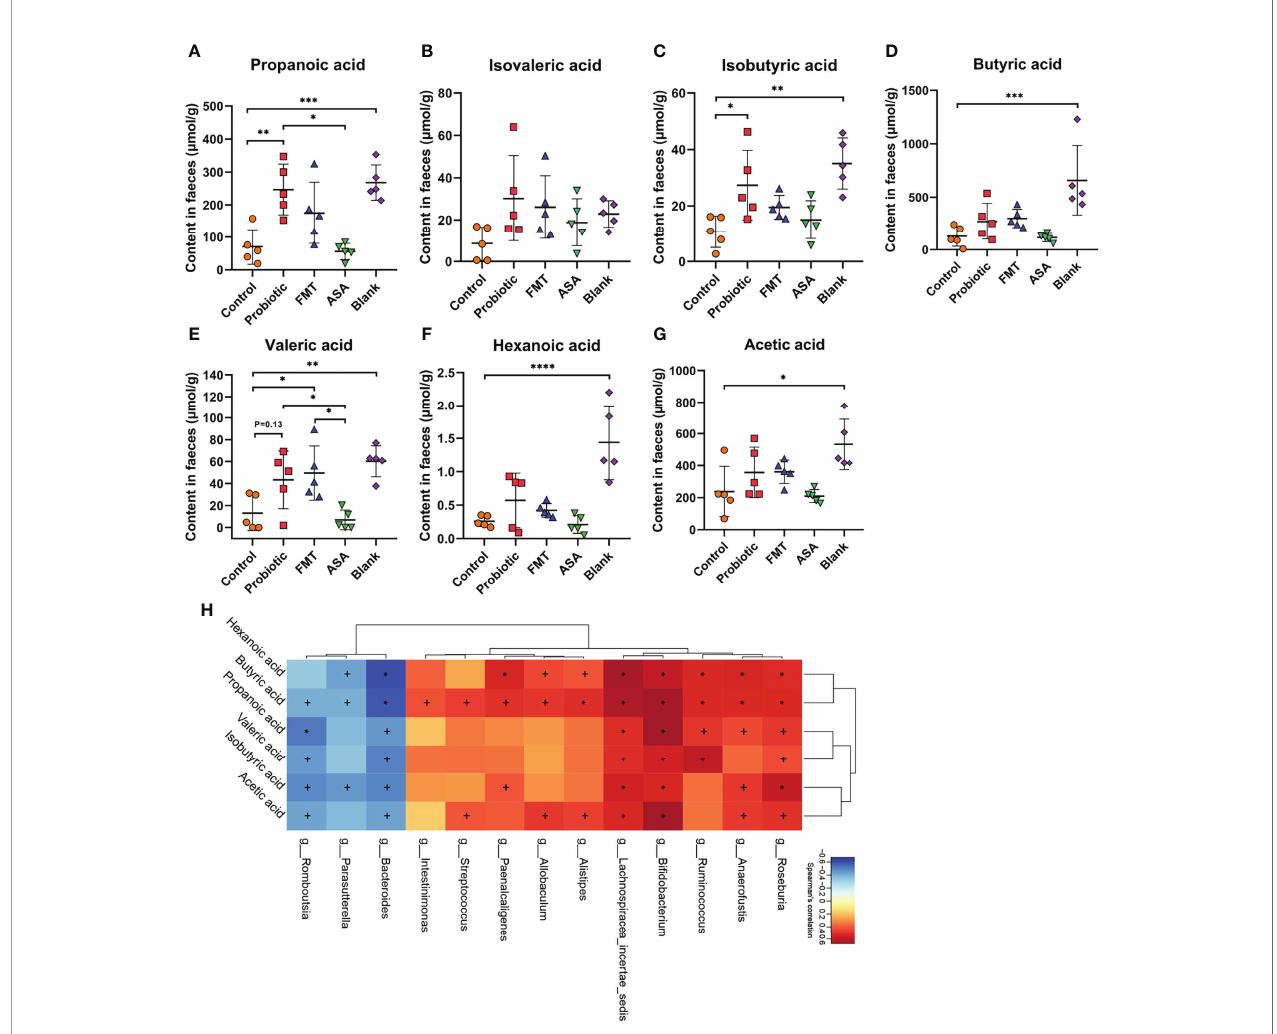
FIGURE 5 | The concentration of fecal SCFAs and their correlation with the gut microbiome. (A – G) The concentration of 7 main kinds of SCFAs (propanoic acid, isovaleric acid, isobutyric acid, butyric acid, valeric acid, hexanoic acid, and acetic acid) in the feces of blank mice, and DSS-induced colitis mice treated with PBS, healthy mice donor FMT, 5-ASA, or the probiotic cocktail. One-way ANOVA test was utilized, and data were shown as mean ± SD. (H) The Spearman correlation analysis illustrated the relationship of SCFAs and gut microbiota. + p < 0.05; ∗ p < 0.01. DSS, dextran sodium sulfate; PBS, phosphate buffered saline; FMT, fecal microbiota transplantation; 5-ASA, 5-aminosalicylic acid; SCFAs, short-chain fatty acids. *p < 0.05; **p < 0.01; ***p < 0.001; ****p <